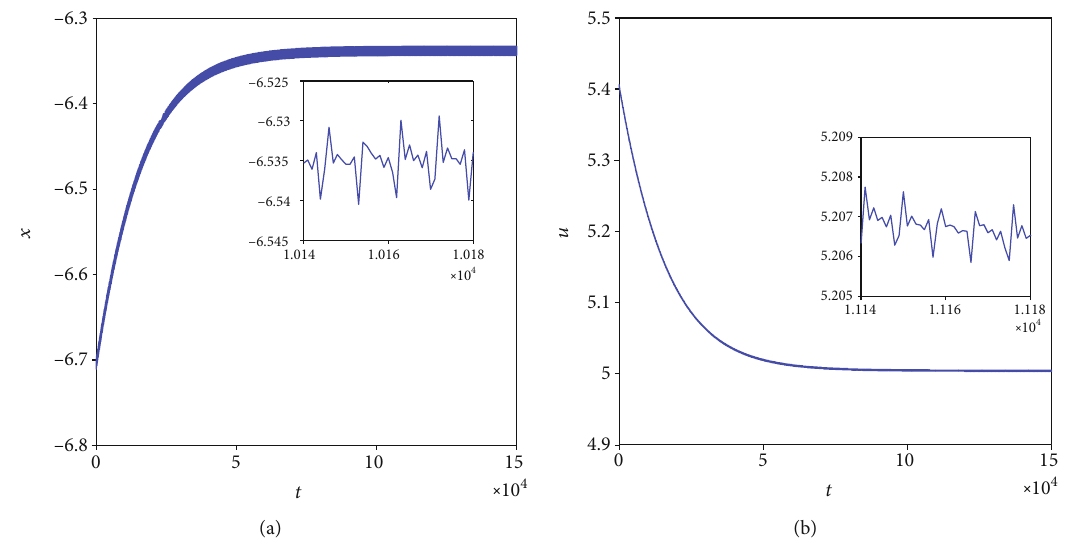
Figure 11: Firing pattern of membrane potential in model (2) with k = 0 : 1 , I